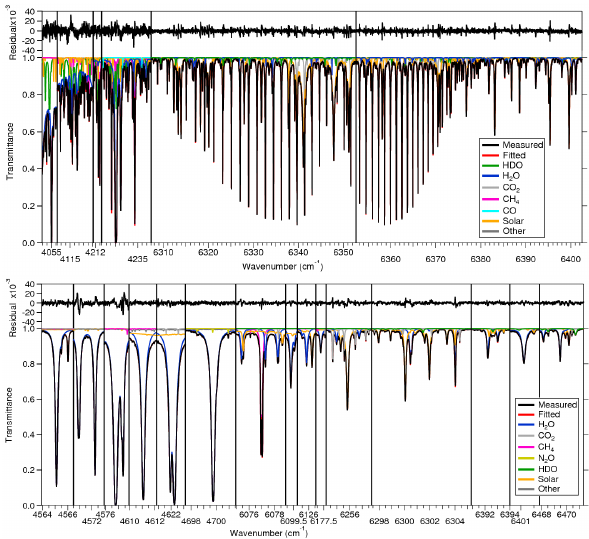
Fig. 5. Spectral fit of the TCCON HDO (top panel) and H 2 O (bot- tom panel) retrieval at Orleans, France, on 31 July 2010. The hor- izontal lines indicate the boundary of the fit windows given in Table 1.